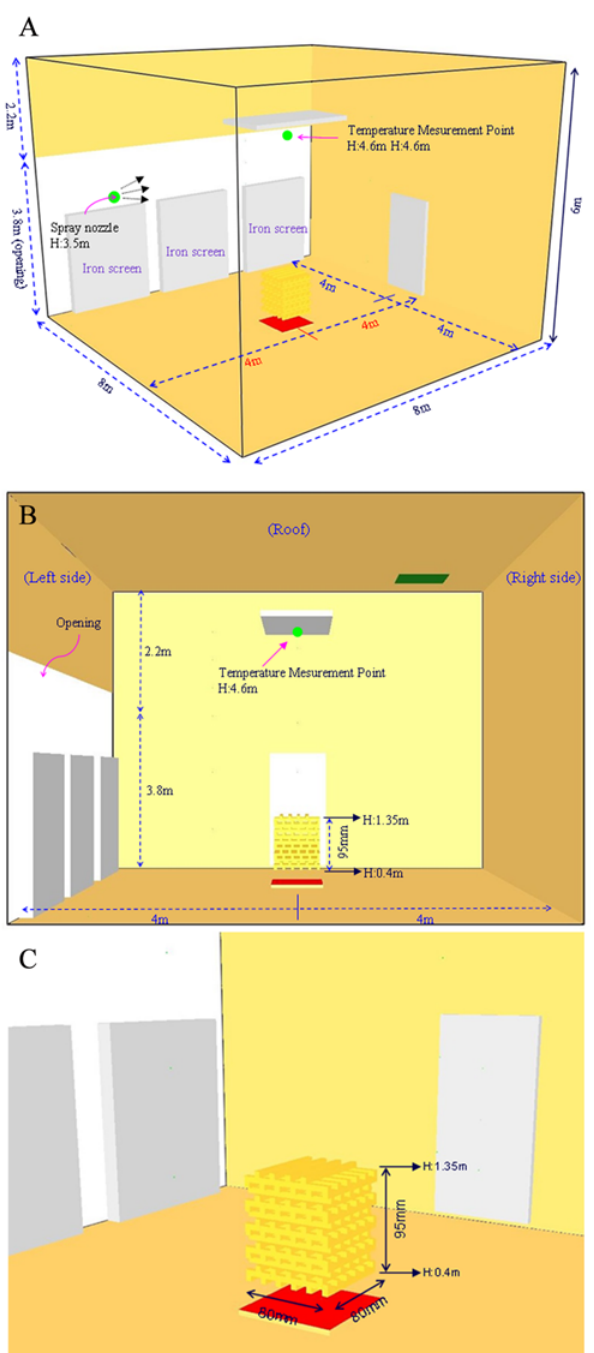
Fig 5. A: Three-dimensional isometric view of the simulation model. B: Sectional view of the simulation model. C: Isometric view of wood model.